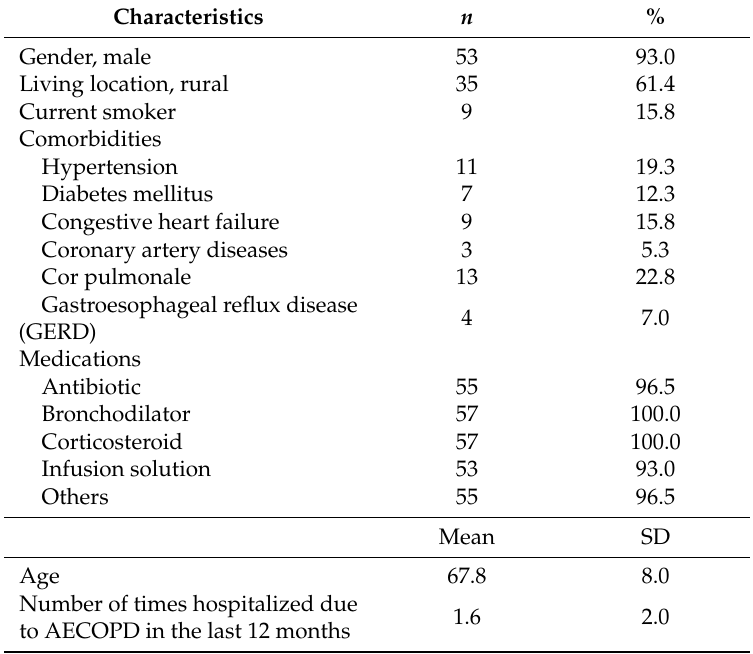
Table 1. Demographic and clinical characteristics ( n = 57).